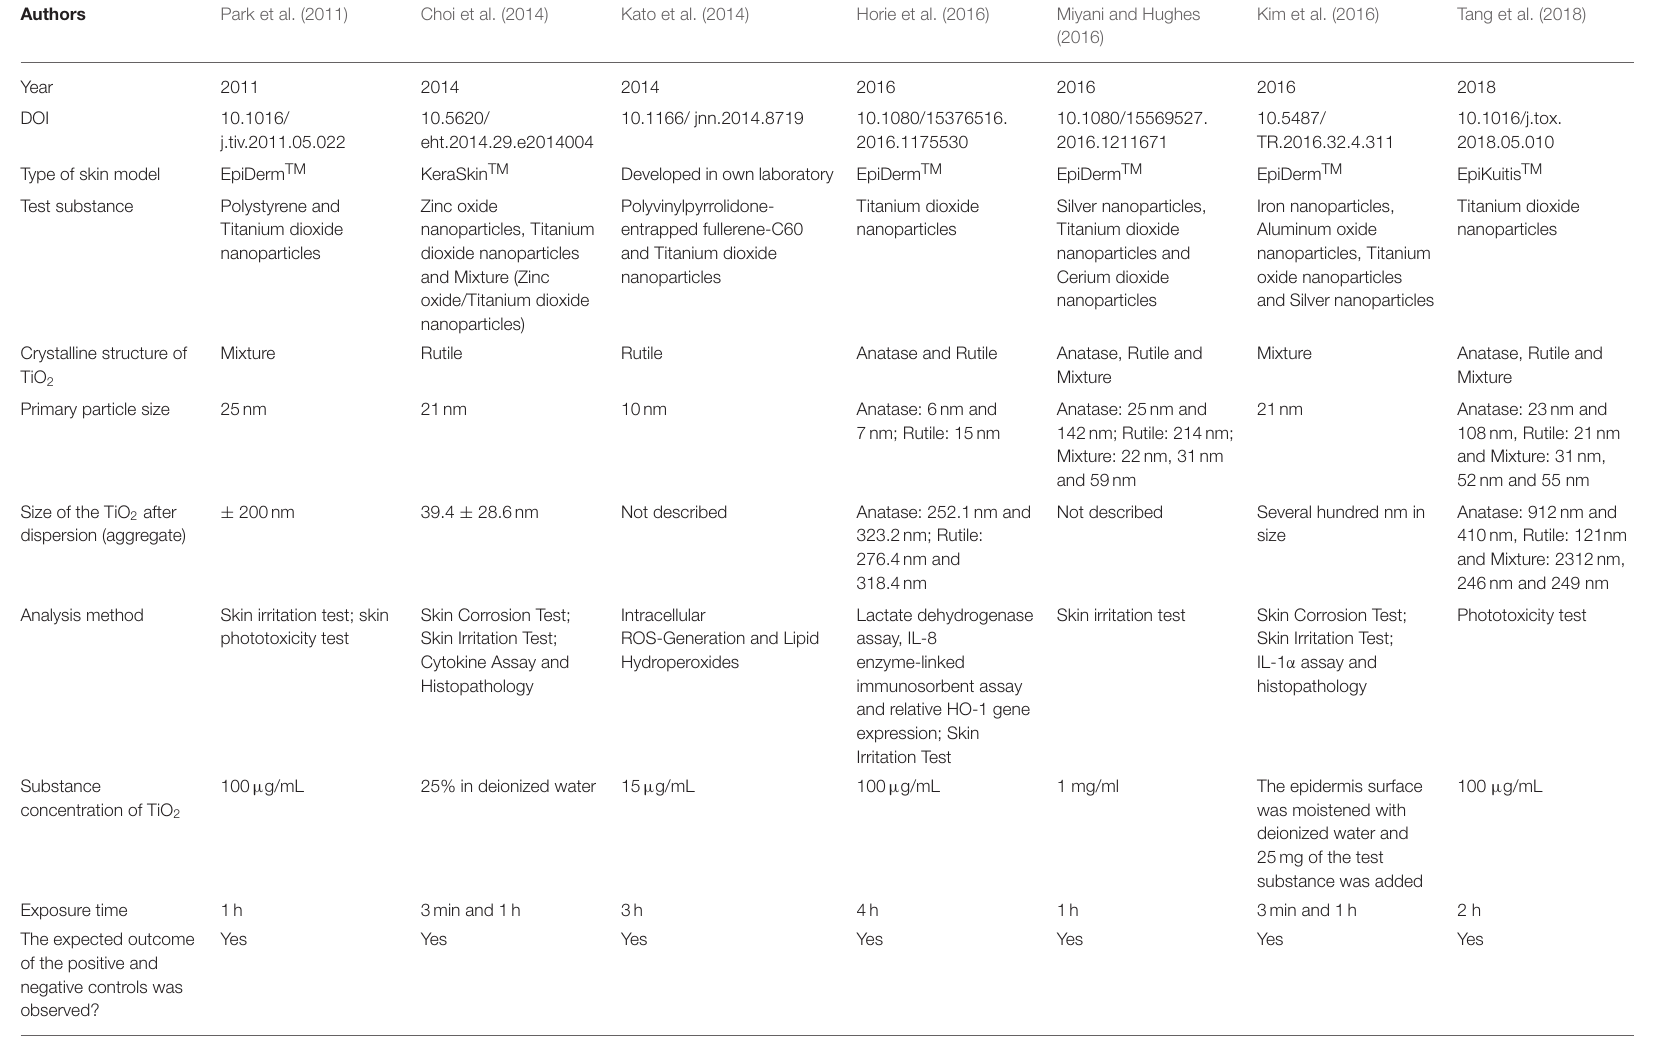
TABLE 4 | Extraction of data from selected